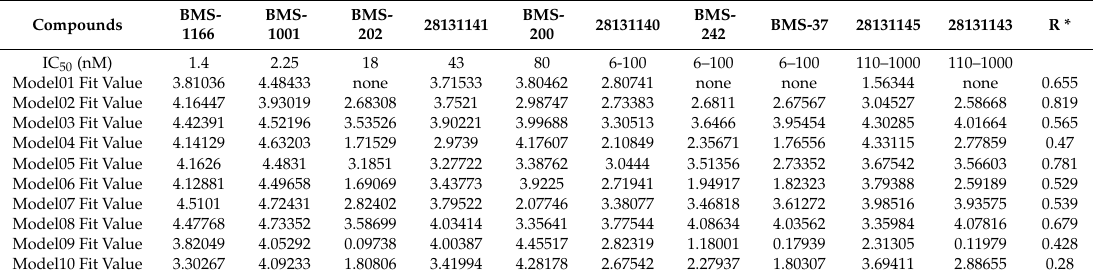
Table 3. Compound experimental IC 50 values and predicted fit values of 10 pharmacophore models.